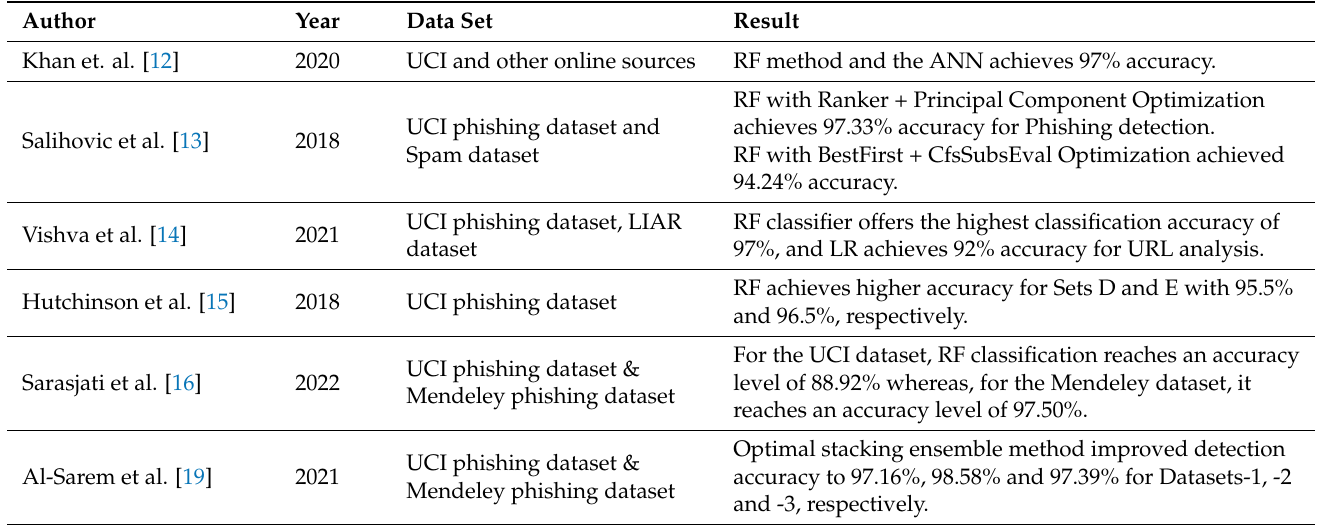
Table 1. Outline of related